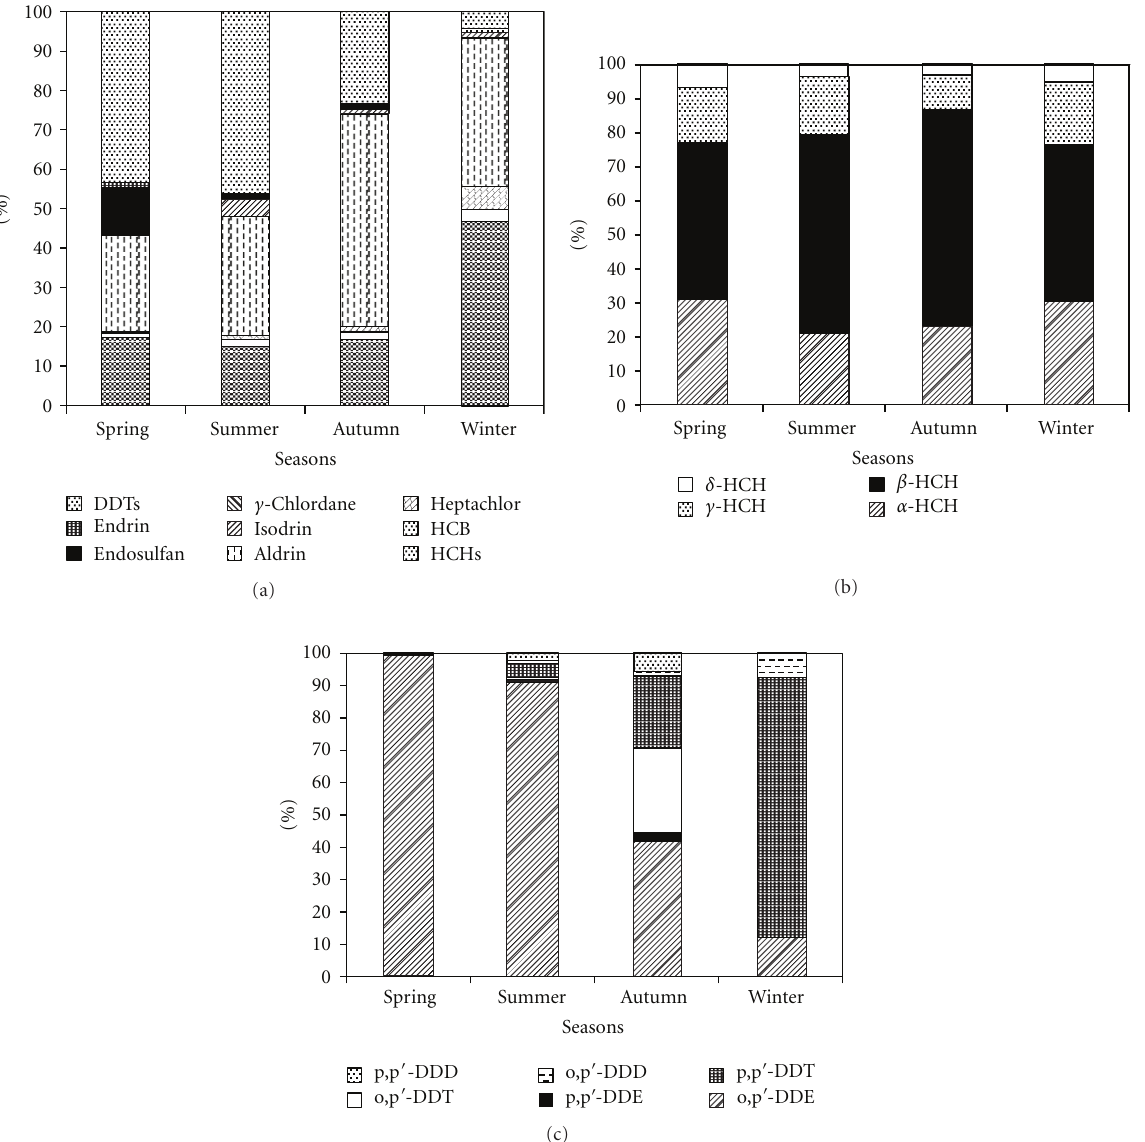
Figure 5: Seasonal changes of the composition of (a) OCPs, (b) HCHs, and (c) DDTs in the